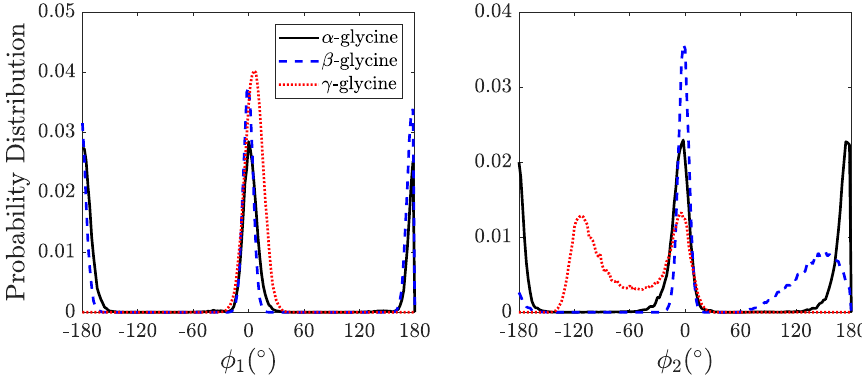
Figure 3. Relative orientation vectors of the molecules in the known polymorphs of glycine. ( Left ) distribution of φ 1 angles, ( right ) distribution of φ 2 angles. Distributions were obtained from 1 ns long NPT simulations of α -, β -, and γ -glycine